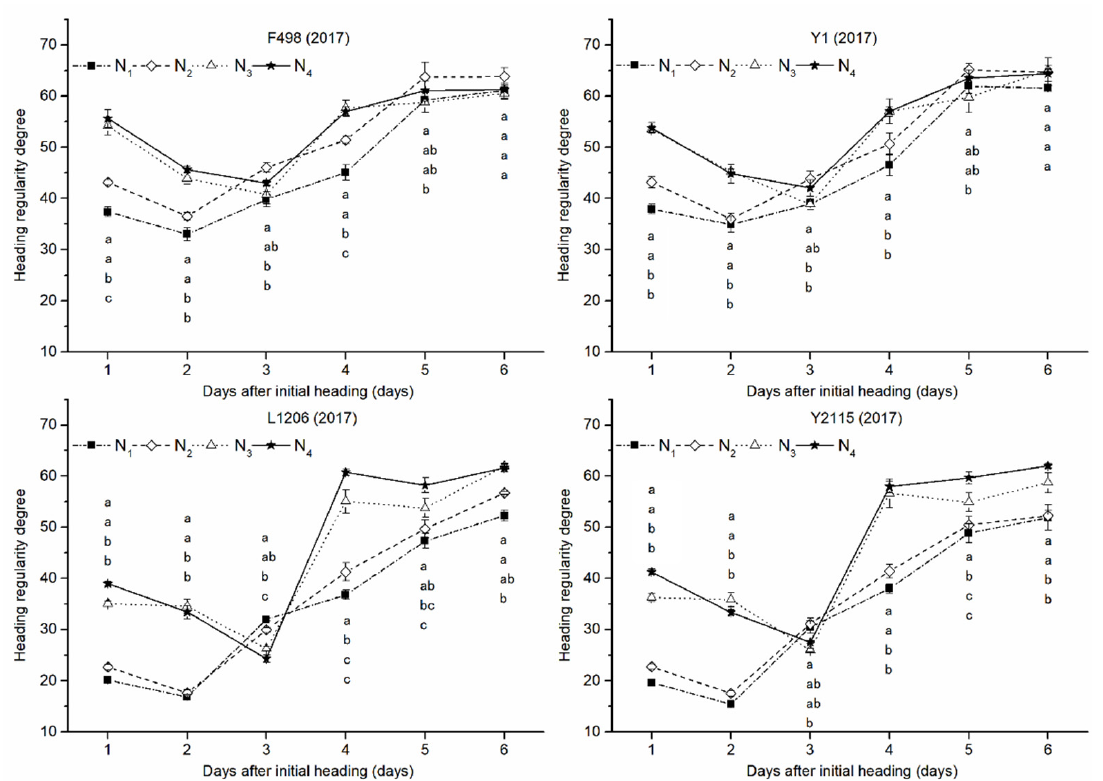
Figure 1. Dynamic changes in the rice heading uniformity over six days after the initial heading in the year 2013. N1, N2, N3, and N4 represent the ratios m (base and tillering fertilizer): m (panicle fertilizer) = 75:25, 60:40, 45:55, and 30:70, re- spectively; vertical bars represent means ± SEs. Four groups of letters from top to bottom in the same column indicate statistical significance at p = 0.05 among different nitrogen management regimens from large to small within the same time period.